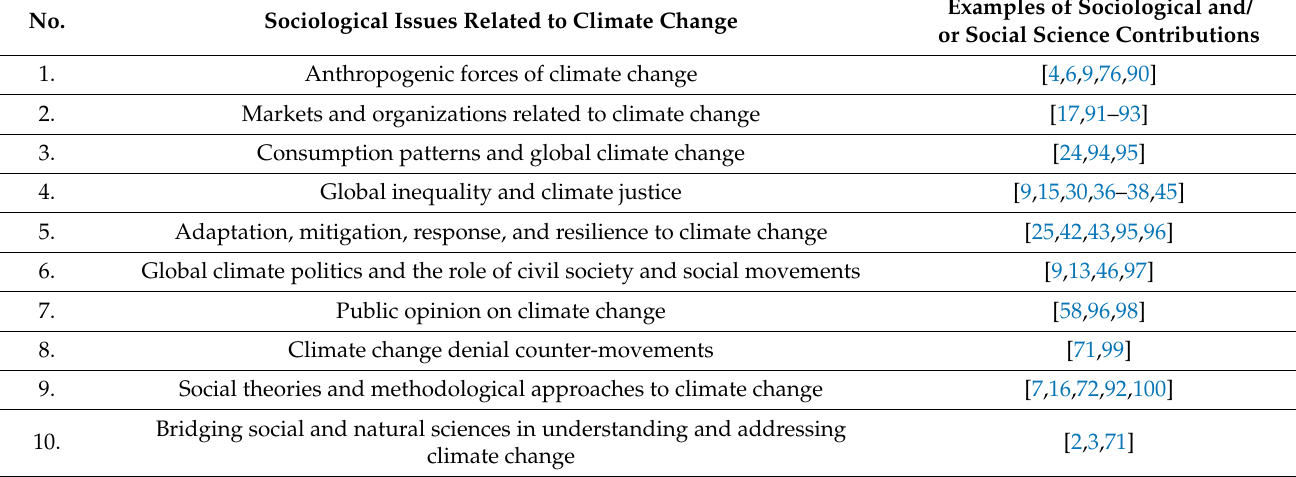
Table 2. Sociological and social science contribution to climate change